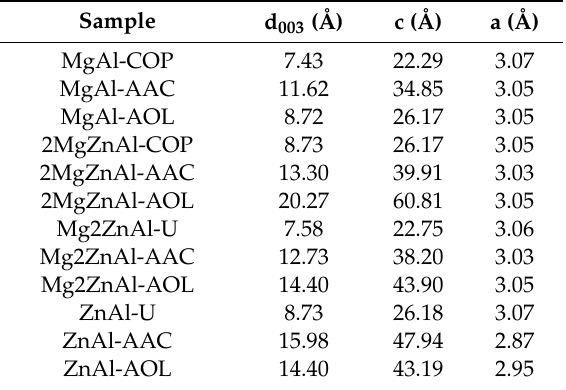
Table 3. Cell parameters of fresh and modified samples.